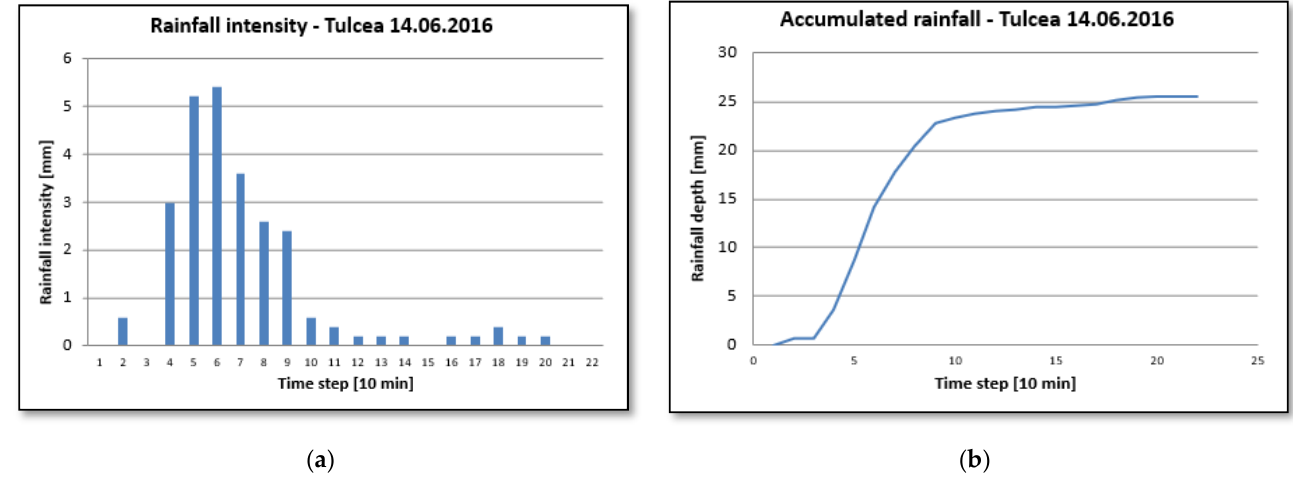
Figure 9. The 14 June 2016 rainfall event: ( a ) hyetograph; ( b ) rainfall mass curve.